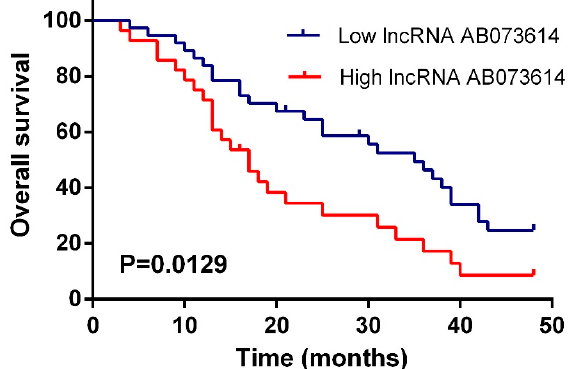
Figure 2. Overexpression of AB073614 indicated an unfavorable prognosis. Kaplan-Meier survival analysis of overall survival in 65 patients based on AB073614 expression status.